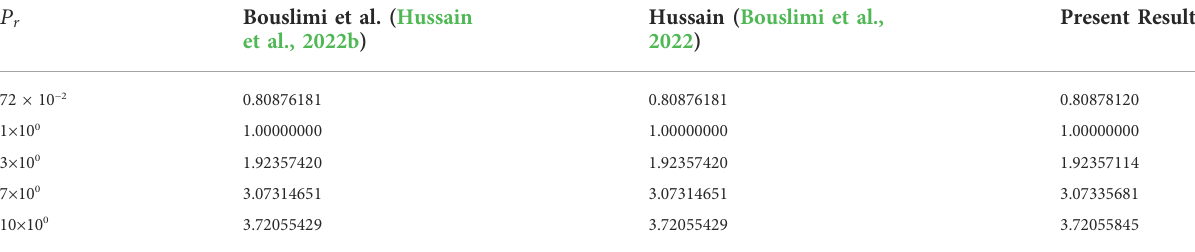
Present Results